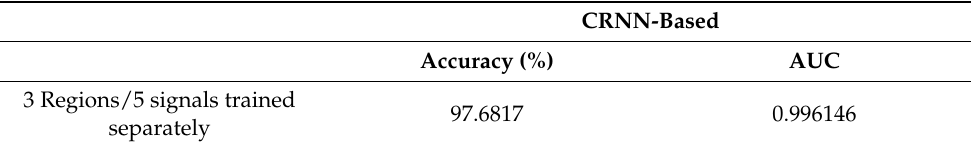
Table 3. Accuracy and AUC of CRNN-based model.